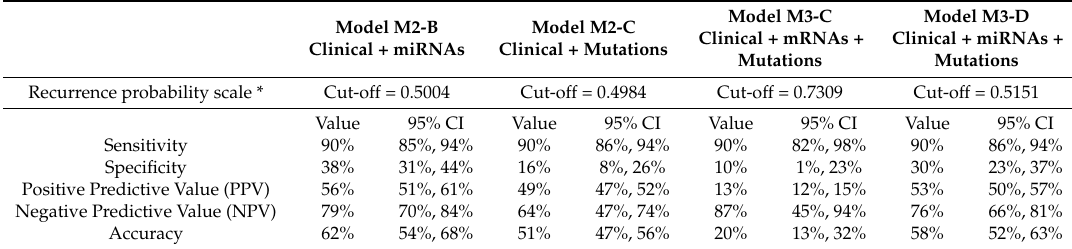
Table 4. Validation of prediction models using data from TCGA EEC dataset. As described in the Methods section, the threshold cut-off values were selected to attain a sensitivity of around 90% and the specificity and negative predictive value. The goal was to create models that would capture at least 90% of the high-risk cases, while ruling out most low risk ones. Recurrence probability scale *: 1/(exp(-score) + 1), where score is the resulting value of the prediction model on a log scale.